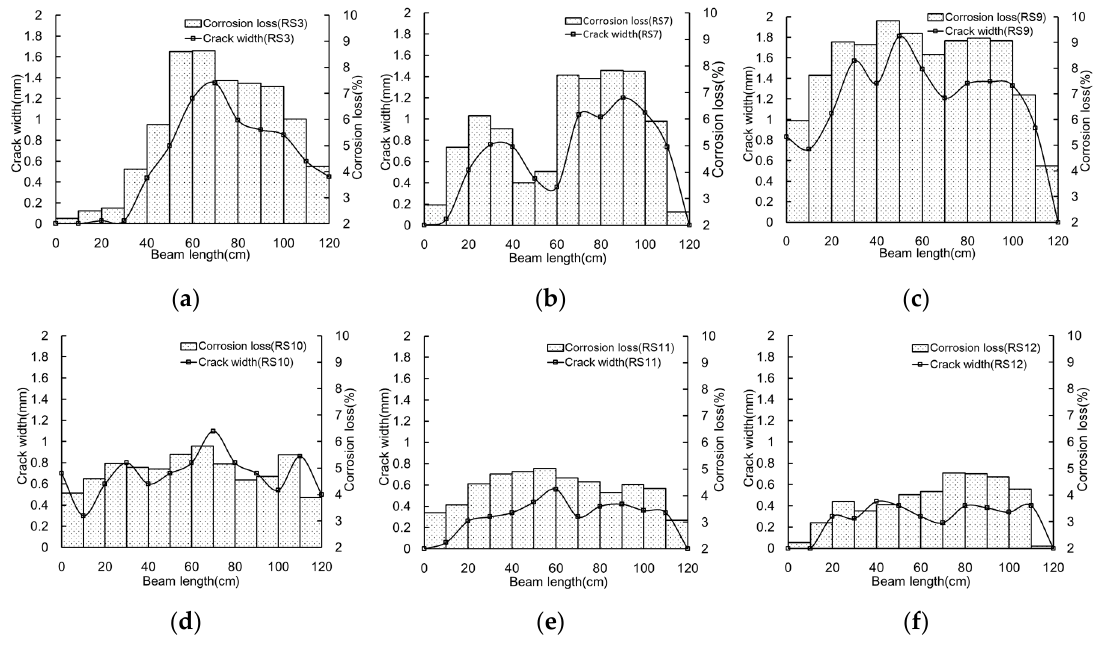
Figure 7. Crack width and corrosion loss (group RS): ( a ) RS3; ( b ) RS7; ( c ) RS9; ( d ) RS10; ( e ) RS11; and ( f ) RS12.